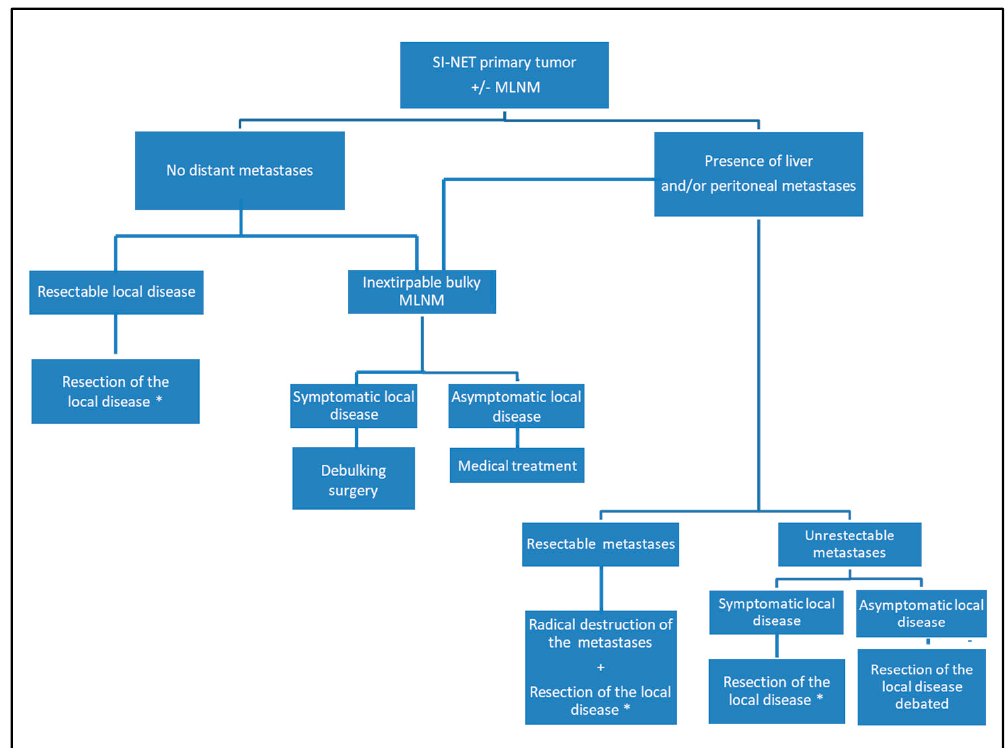
Figure 7. Proposed algorithm diagram for surgical indications of resection for SI-NET local disease. *Resection of all the primary tumors (after manual palpation of the entire small bowel) + systematic mesenteric lymphadenectomy (with at least 8 or 12 removed LN).